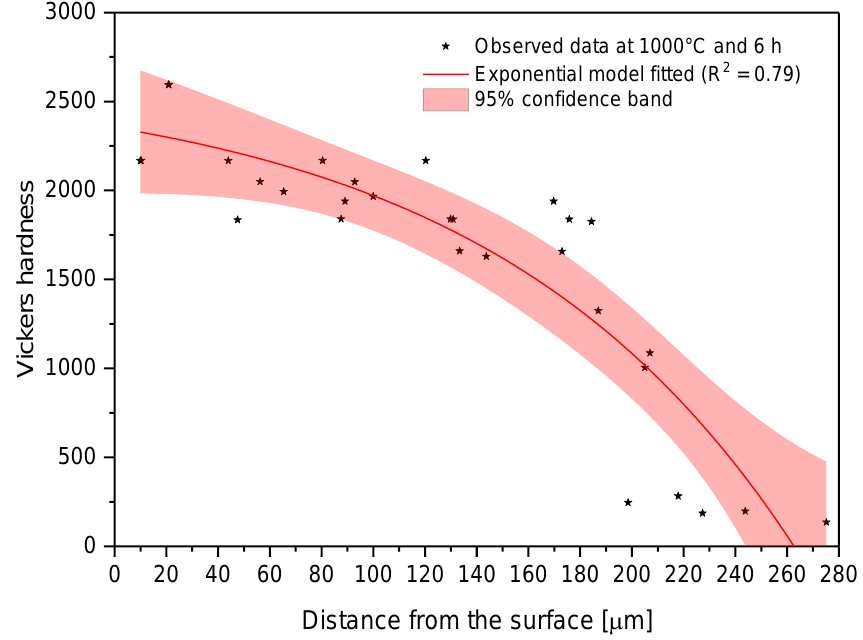
Figure 10. Changes in microhardness as measured away from the surface for a sample treated at 1000 °C and 6 h.